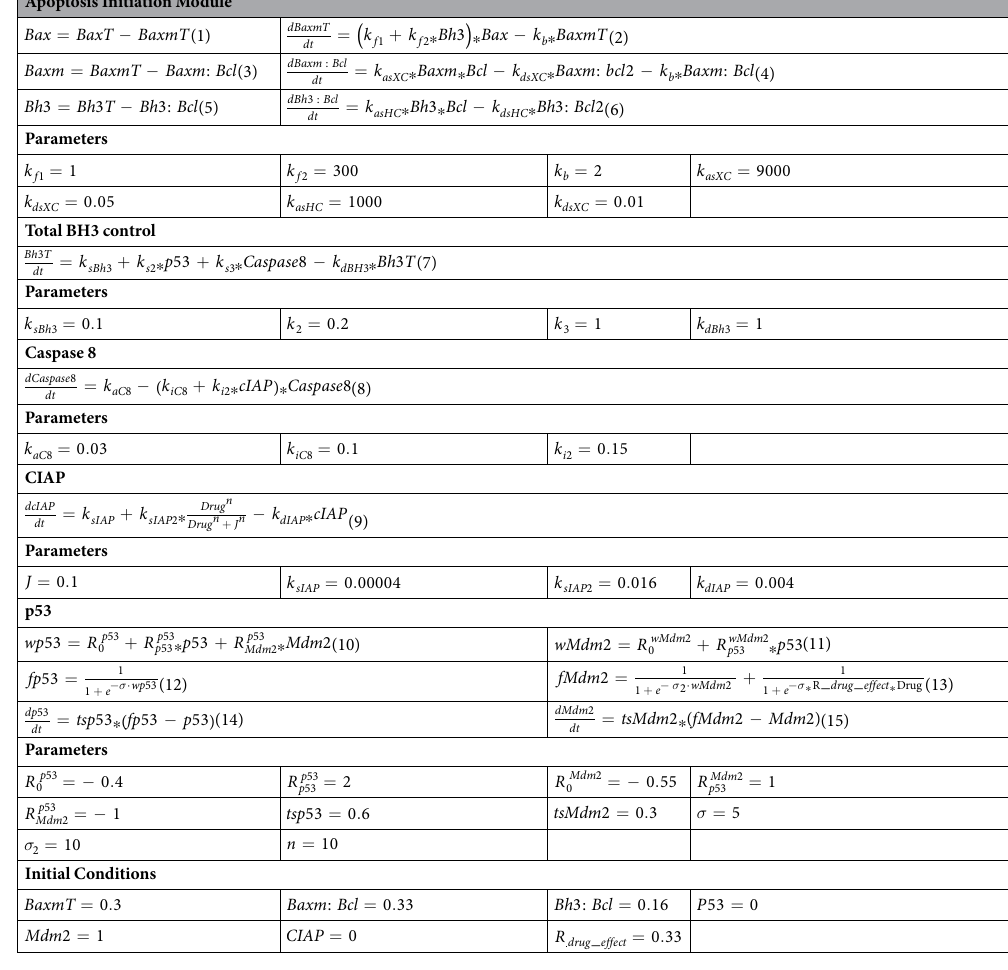
Table 1. Equations and parameters of the